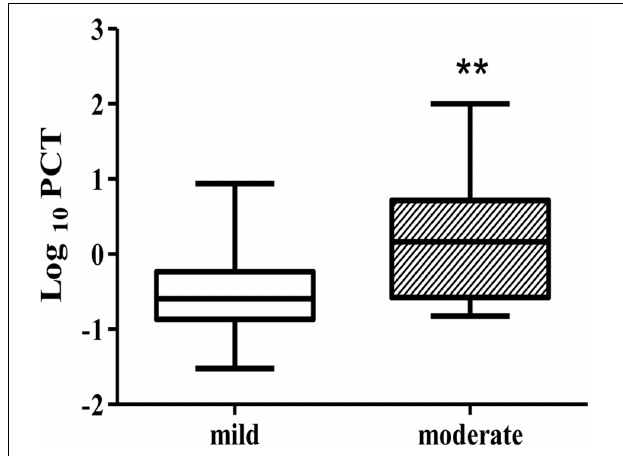
FIGURE 1 | Procalcitonin (PCT) levels of patients with mild CDI and moderate CDI. The box plot shows the median (bold line), the first quartile (lower border of the box) and the third quartile (upper border of the box). ∗∗ p < 0.01.